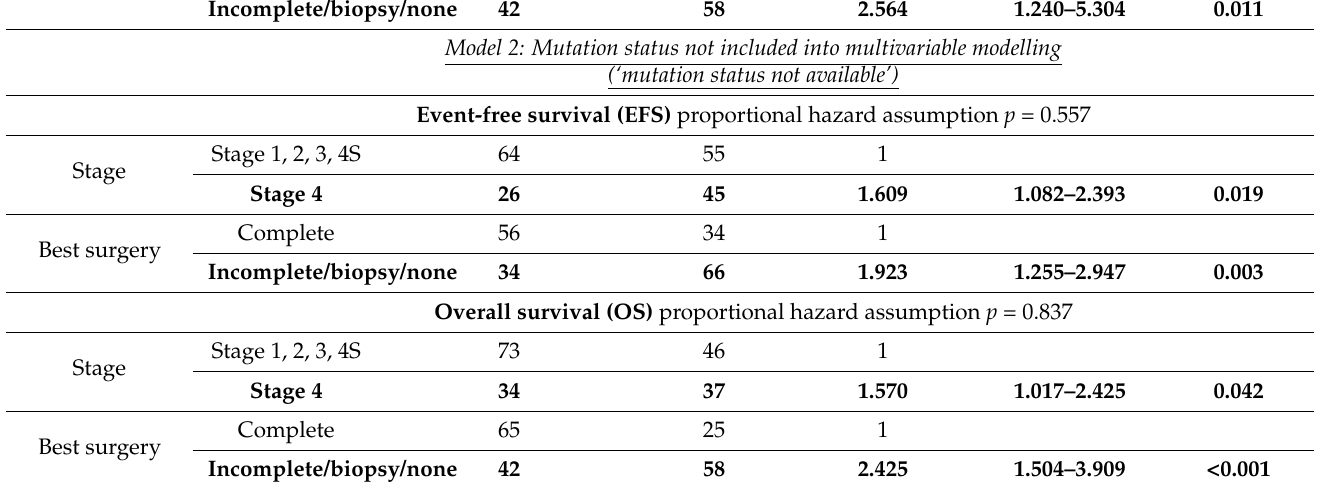
Model 2: Mutation status not included into multivariable